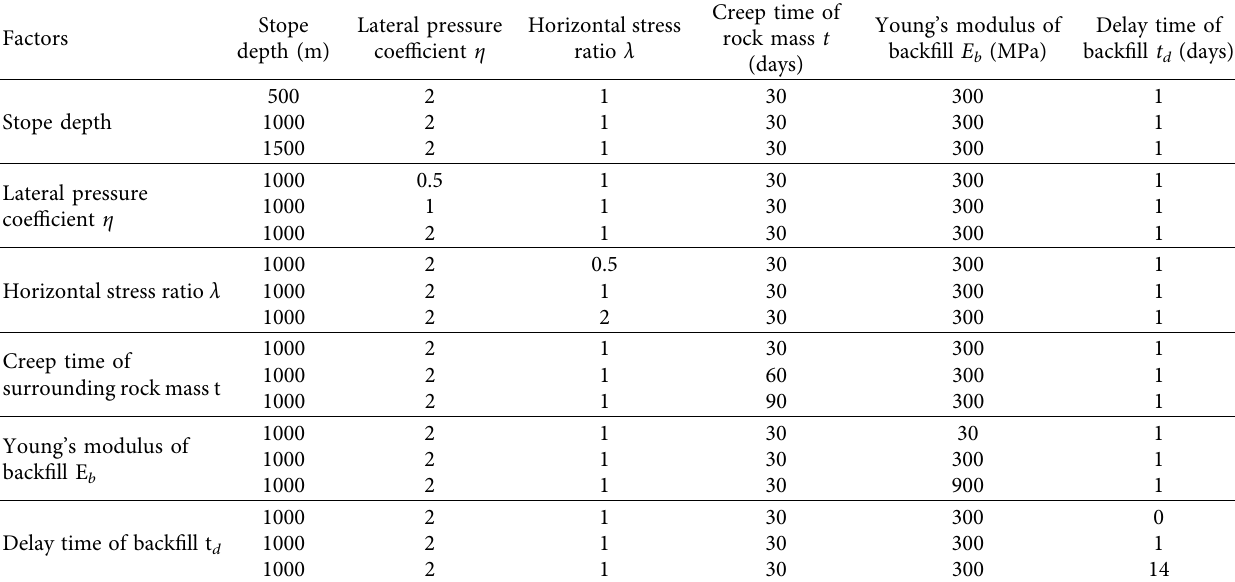
Delay time of backfill t